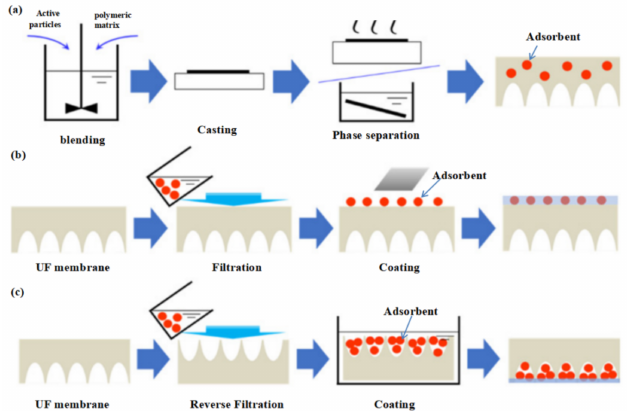
Figure 2. Schematics of some typical methods for the preparation of multifunctional ultrafiltration membranes: ( a ) blending, ( b ) surface coating, and ( c ) reverse filtration. Reprinted/adapted with permission from Ref. [50]. Copyright © 2020